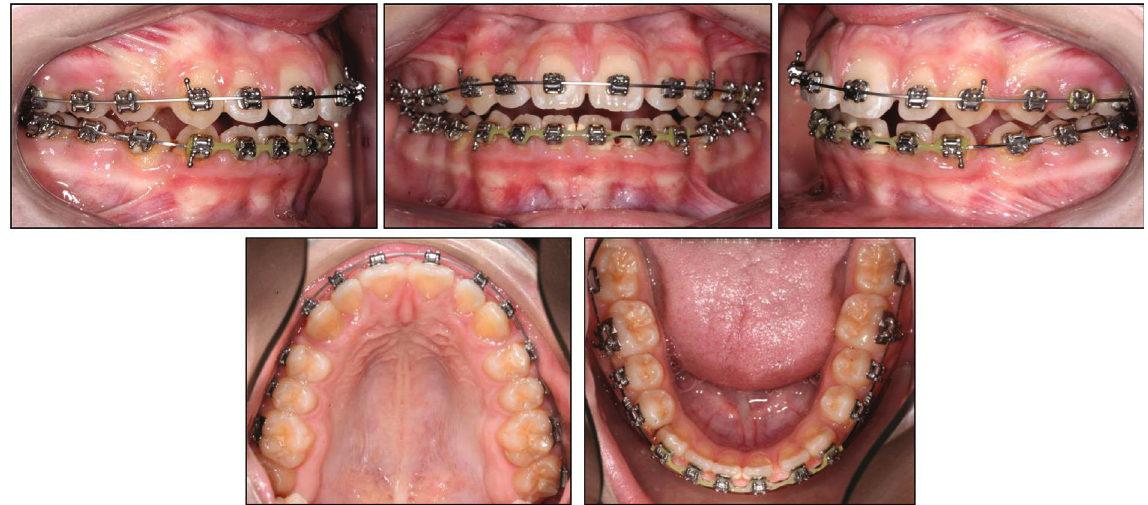
Figure 4: The patient ’ s intraoral photographs taken after 8 months of orthodontic treatment.